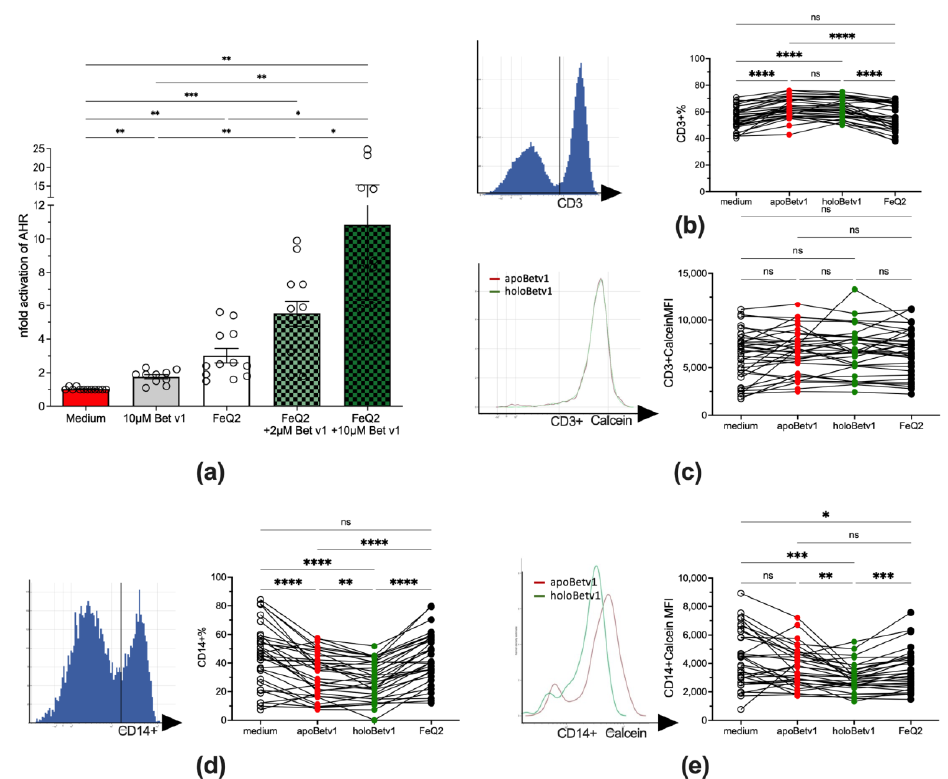
Figure 3. Shuttling of FeQ2 by Bet v 1 activates the anti-inflammatory aryl hydrocarbon receptor and increases labile iron in monocytes. ( a ): AhR activation by quercetin-iron complexes is increased upon addition of Bet v 1. AZ-AhR cells were treated with 45 µM of iron-quercetin complexes alone or with 2 µM and 10 µM Bet v 1, for 18 h before luciferase-activity was measured in the supernatant. Summary from six independent experiments normalized to medium alone. Flowcytometric analyses of PBMCs ( n = 34) stimulated with medium, iron-quercetin (FeQ2), apoBet v 1 alone or in combination thereof (holoBet v 1). ( b ): Gated CD3+ cells and summary of relative CD3+ expression and ( c ): mean fluorescence intensity (MFI) of the calcein signals thereof. ( d ): Gating and summary of relative numbers of CD14+ expression as well as ( e ) MFI of the calcein signals of stimulated CD14+ cells. An increase of intracellular iron results in a lower calcein-signal due to quenching. Data were analyzed in ( a , d , e ) by mixed-effect analysis and ( b , c ) with RM one-way ANOVA. All data were Geisser- Greenhouse corrected and followed by Tukey’s multiple comparisons test. * p < 0.05; ** p < 0.01; *** p < 0.001; **** p < 0.0001; ns = not